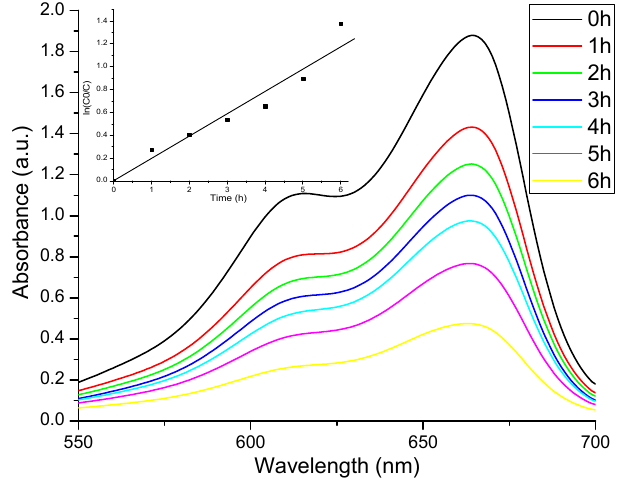
Figure 6. Photocatalytic activity against methylene blue (MB); the pseudo-first-order rate constant k app (h − 1 ) was calculated from the slope of ln(C0 / Ct) versus irradiation time t.